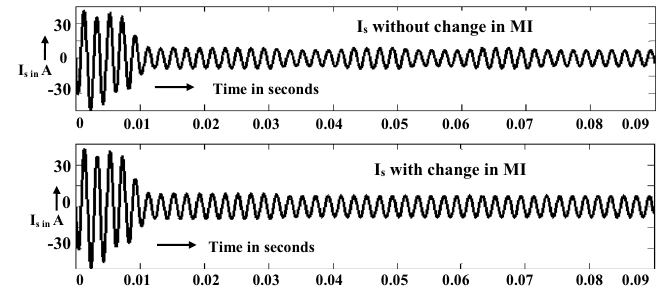
Fig. 16 Current ripple without and with changing